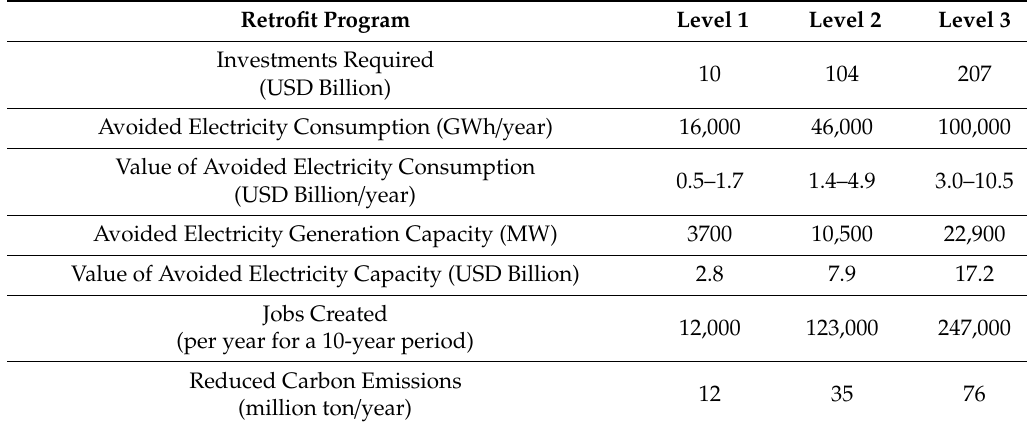
Table 24. Summary of investments and benefits for building energy retrofit programs in Saudi Arabia (Source: [12]).